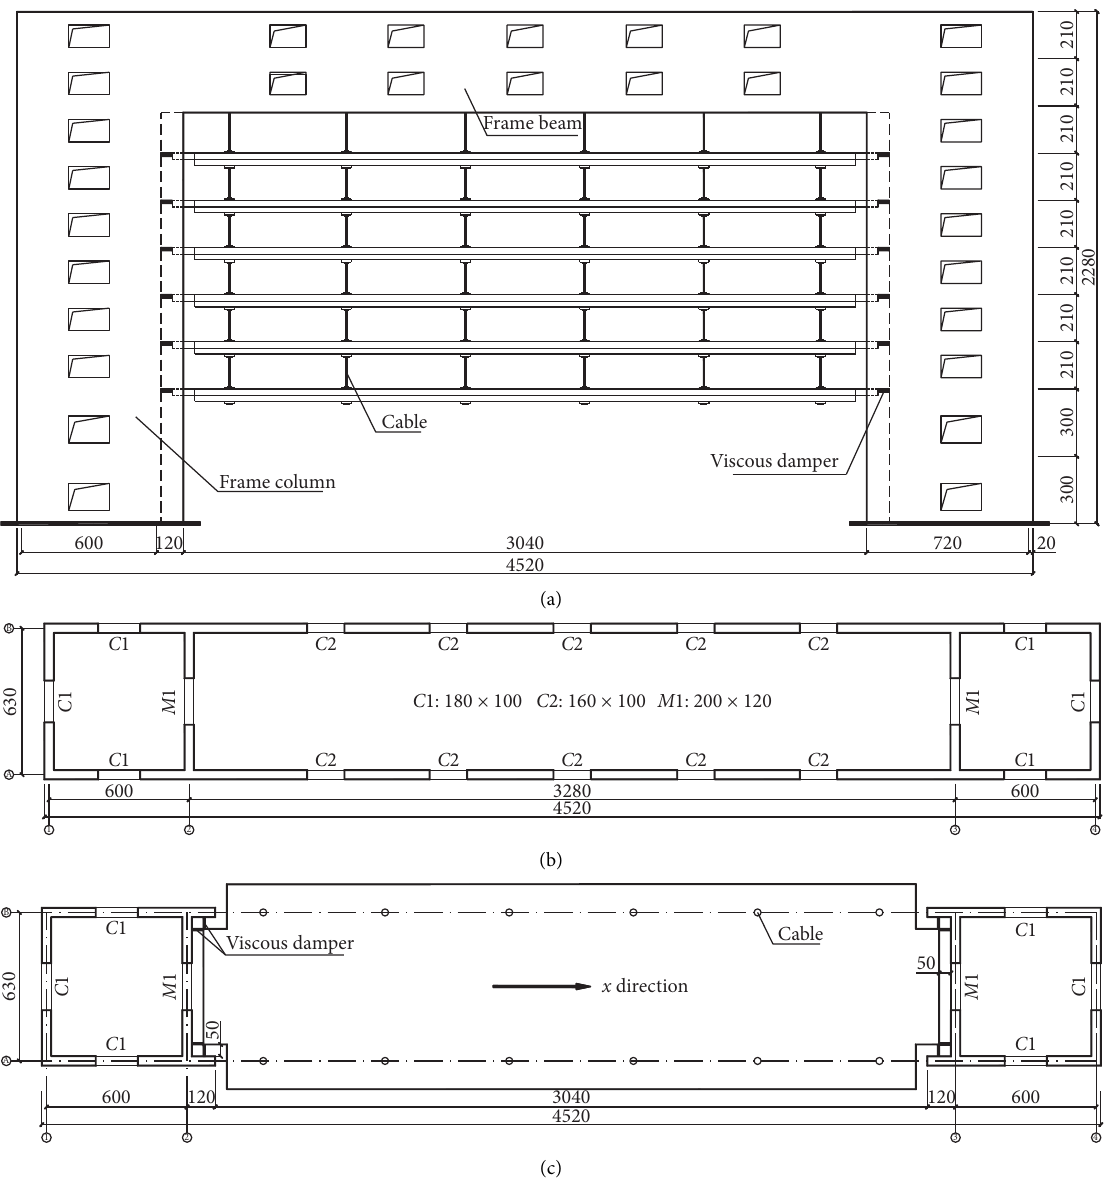
Figure 1: Schematic diagrams of structural plane and elevation. (a) Front view. (b) Frame-beam floor plane. (c) Suspended